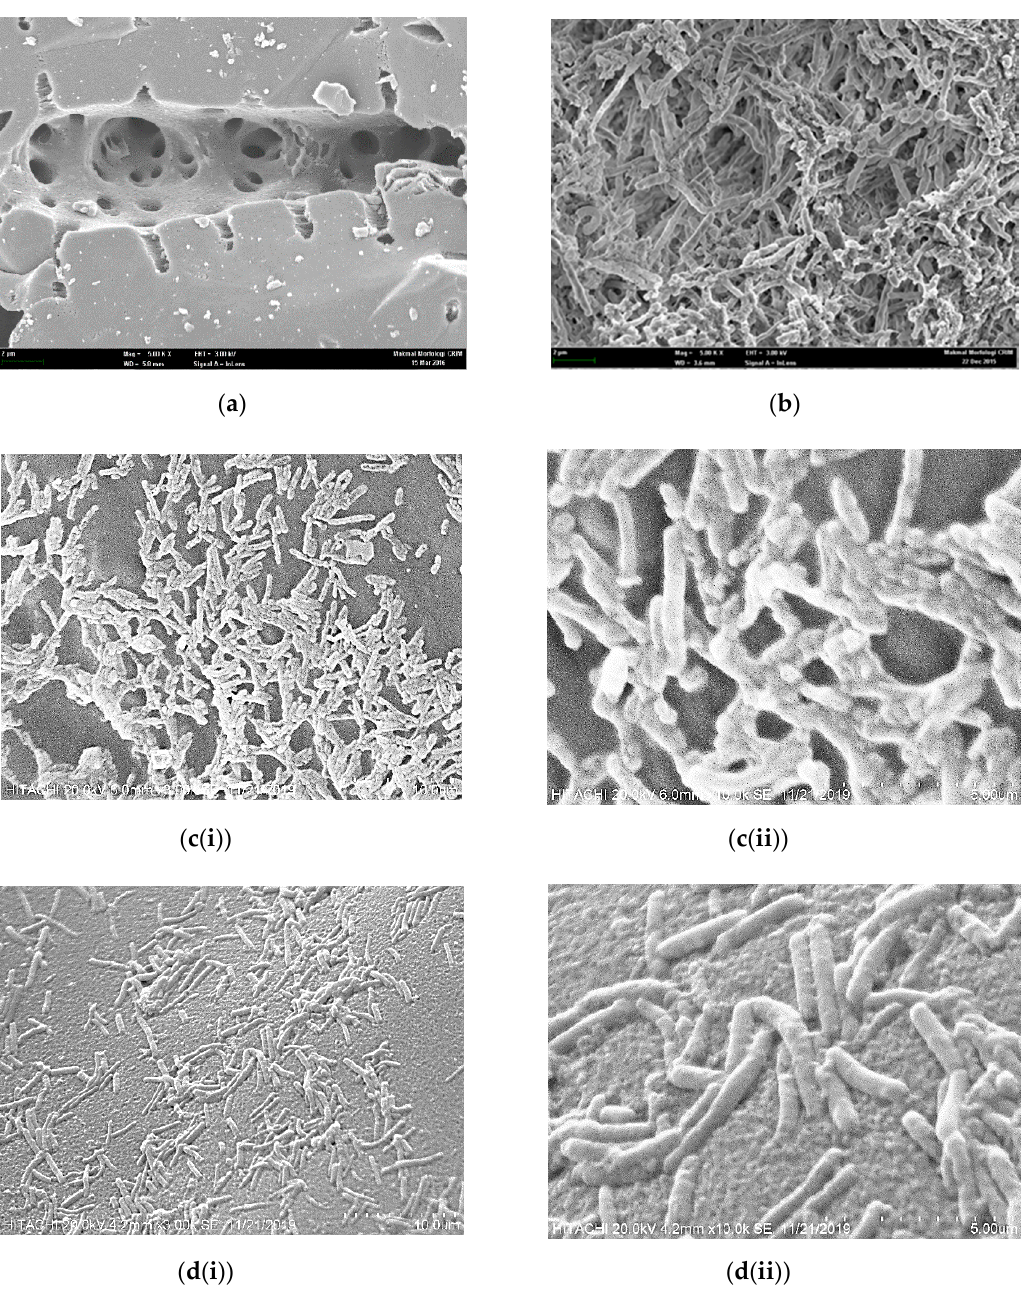
Figure 9. Images of ( a ) clean GAC; ( b ) GAC-attached biofilm; ( c ) immobilised cells on GAC–Alg at ( i ) 3.00 k magnification and ( ii ) 10.00 k magnification; ( d ) immobilised cells on GAC–AlgC at ( i ) 3.00 k magnification and ( ii ) 10.00 k magnification.